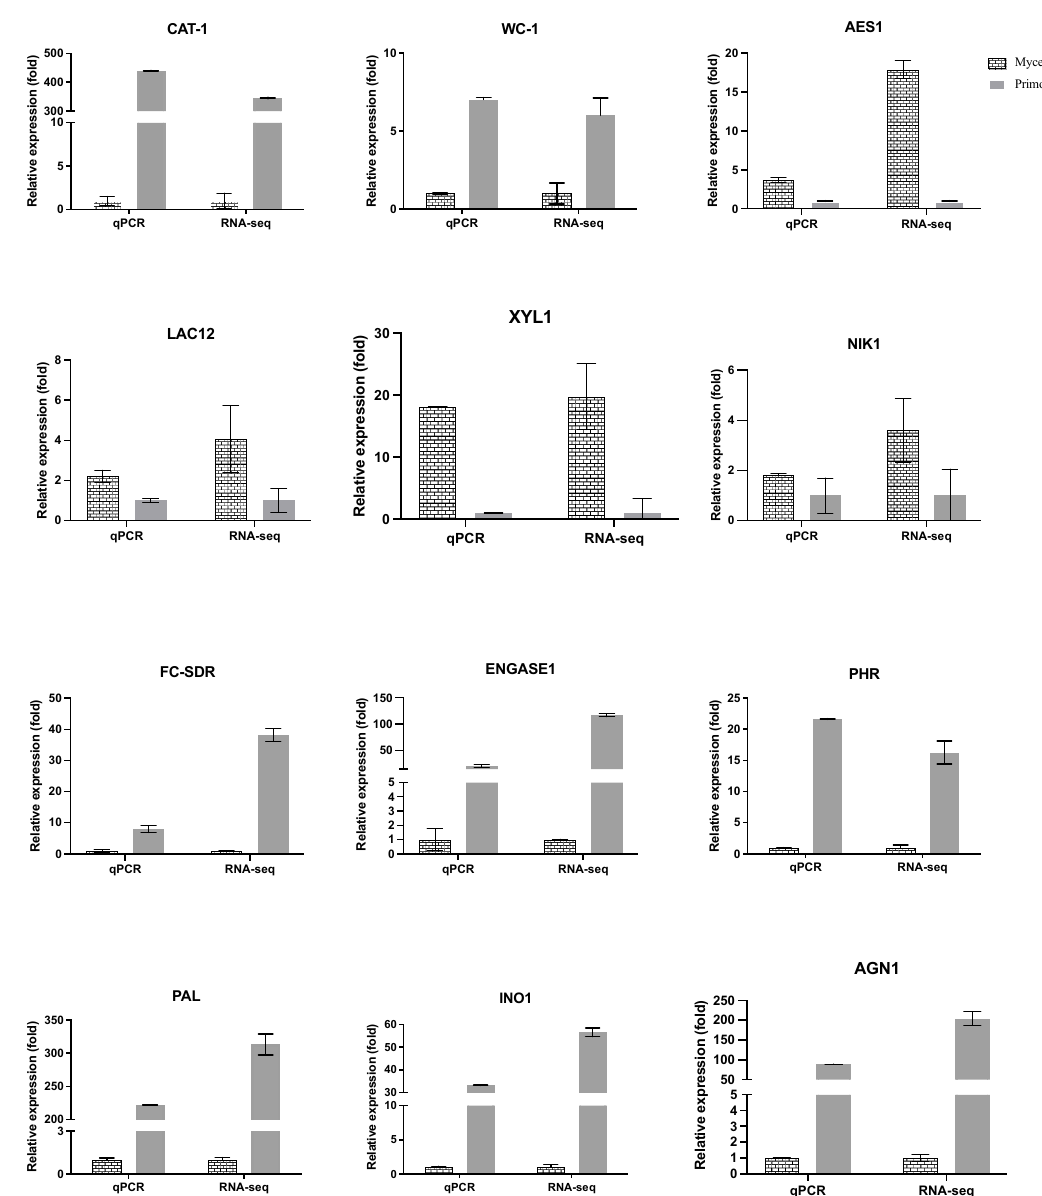
Figure 6. Expression of 12 selected genes as determined by RT-qPCR in comparison with the RNA-seq results. Gapdh expression was used as the internal control. The RT-qPCR values for each gene are expressed as the mean ± SD of three biological replicates.